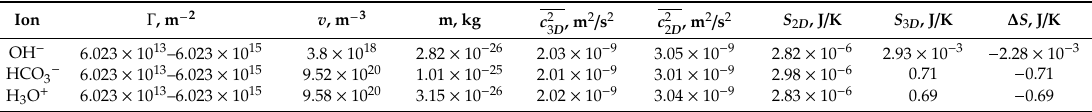
Table 5. Parameters needed for calculation of the change of entropy of the adsorption of OH − , HCO 3 − , and H3O + ions on the air / water interface and the calculated values of the